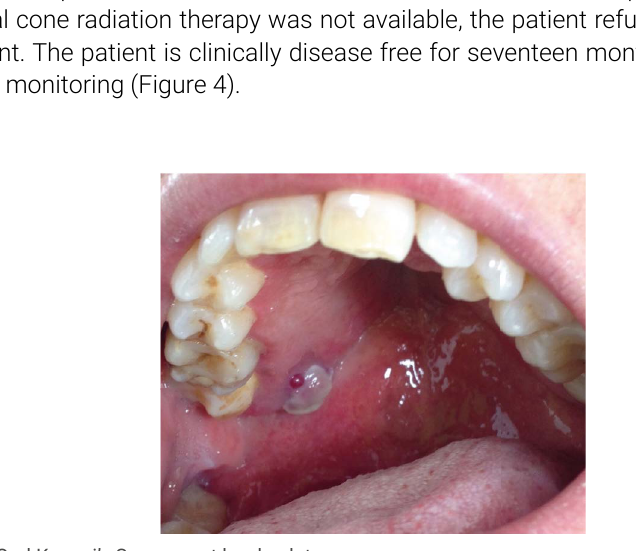
Figure 1. Oral Kaposi’s Sarcoma at hard palate.